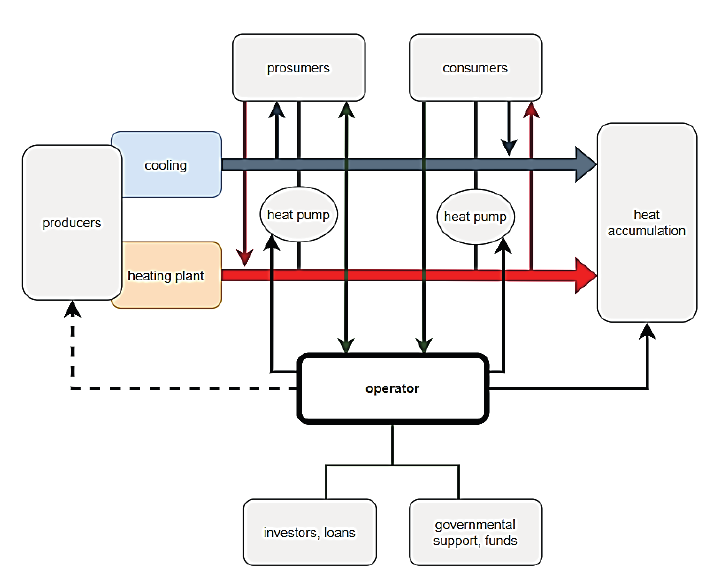
Fig. 2. Scheme of Scenario 1a. Thermal Energy Purchase Agreement with external heat producer .